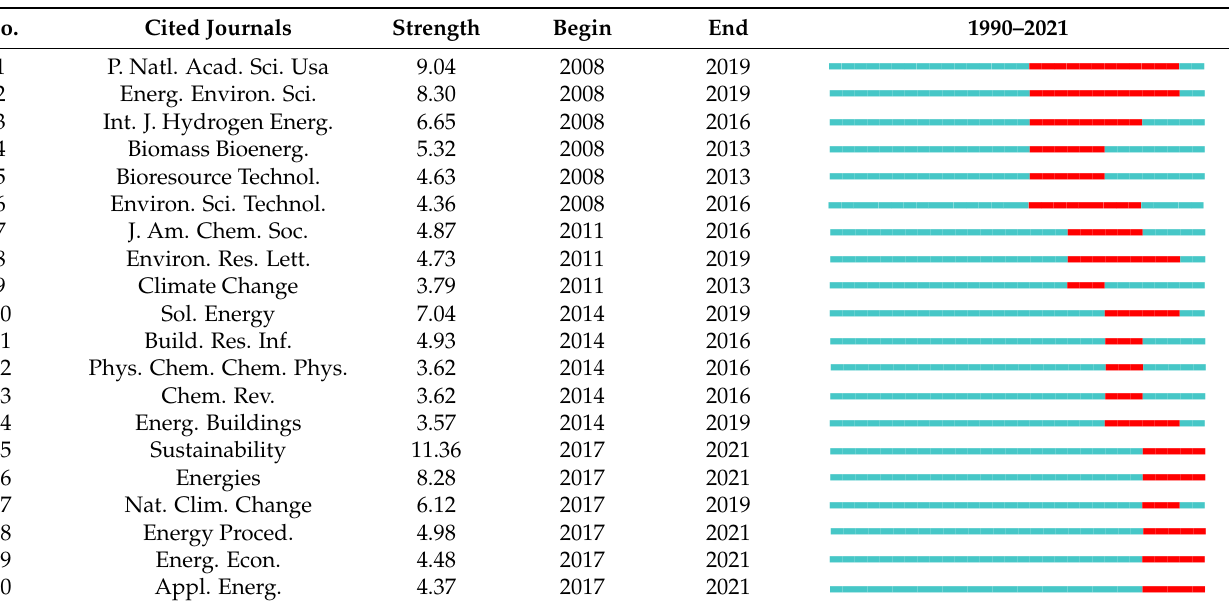
Table 7. Top 20 Cited Journals with the Strongest Citation Bursts.